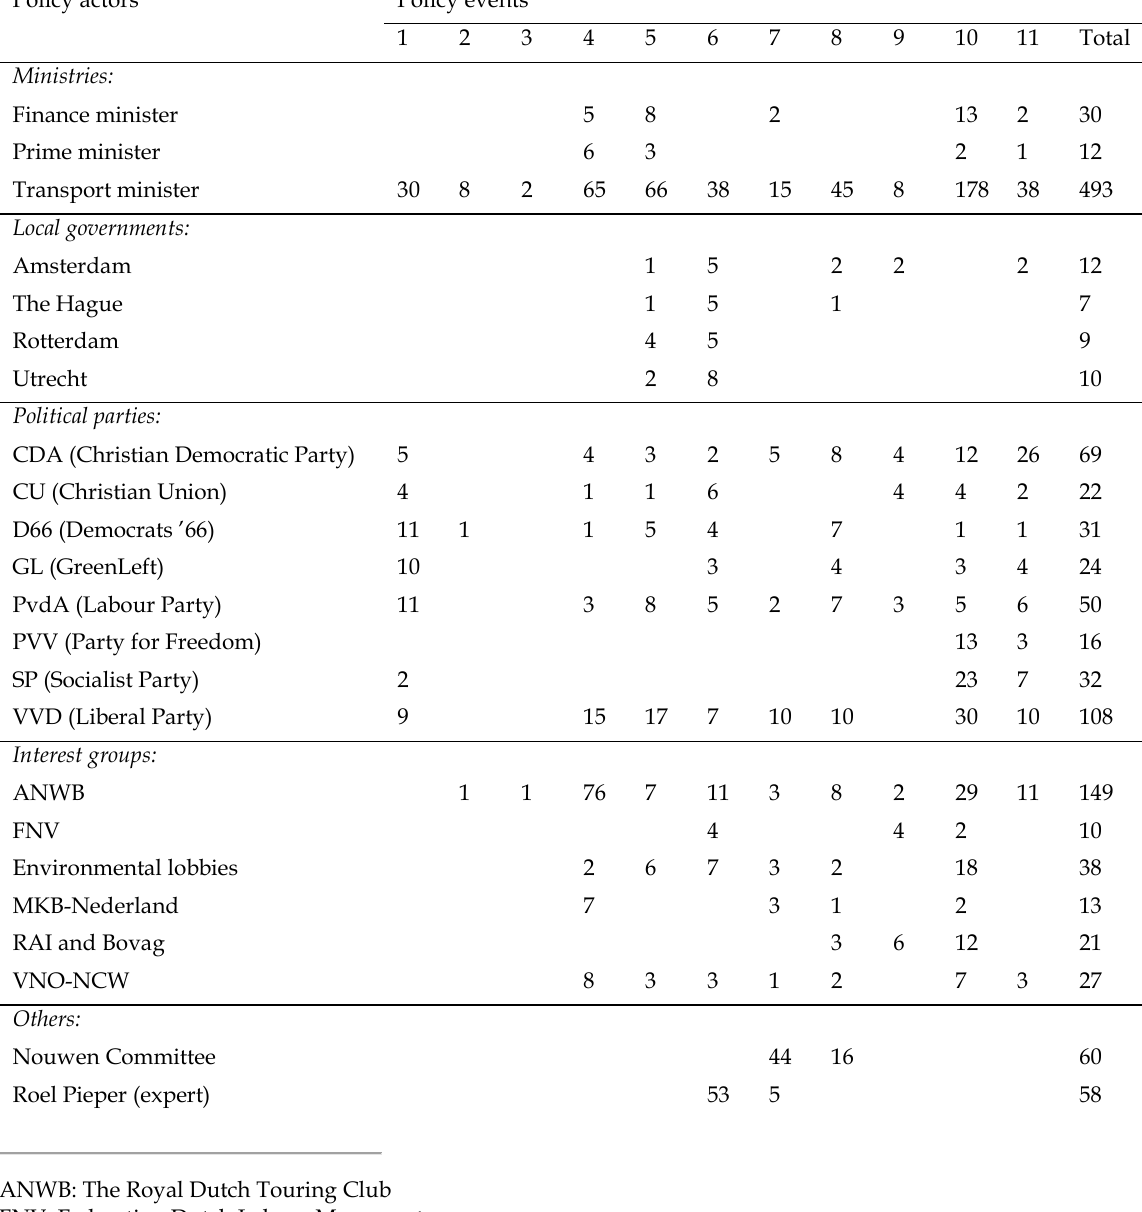
FNV: Federation Dutch Labour Movement MKB-Nederland: Dutch Federation of Small and Medium-sized Enterprises RAI and Bovag: Manufacturers and Importers of Cars and Trucks, and Employers of Companies related to Mobility VNO-NCW: The Confederation of Netherlands Industry and